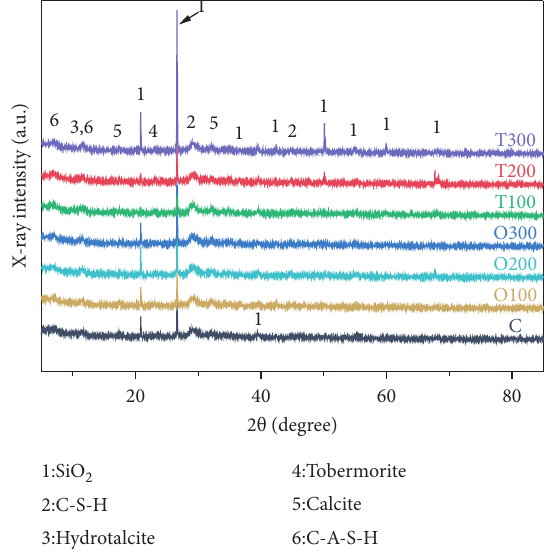
Figure 11: XRD patterns of 28d pastes.